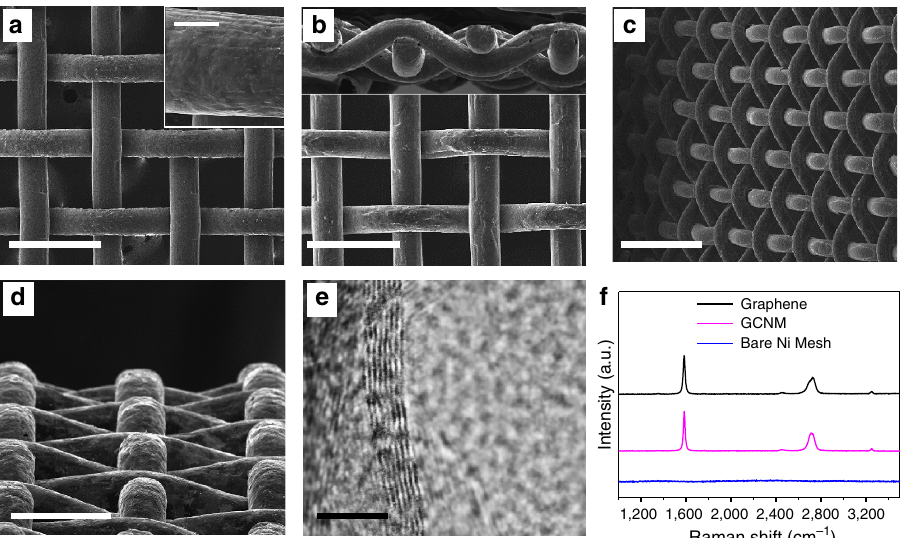
Figure 2 | SEM and transmission electron microscopy (TEM) images of graphene-coated metal mesh and hollow graphene mesh. ( a ) Graphene coated on Ni mesh. Scale bar, 300 m m. Inset is a closer view of graphene coating on metal mesh. Inset scale bar, 40 m m. ( b , c , d ) Pure graphene mesh after etching process. Scale bars are 300, 500 and 200 m m, respectively. ( e ) TEM image of multilayer CVD-grown graphene. Scale bare, 5nm. ( f ) Raman spectra of GCNM, bare nickel mesh, and hollow graphene mesh after etching of